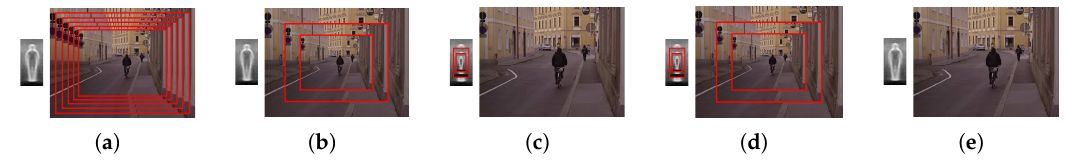
Figure 1. Different multiscale detection strategies. ( a ) Dense image pyramid and single classifier; ( b ) Sparse image pyramid and single classifier; ( c ) Single image scale and sparse classifier pyramid; ( d ) Sparse image pyramid and sparse classifier pyramid; ( e ) Single image scale and single